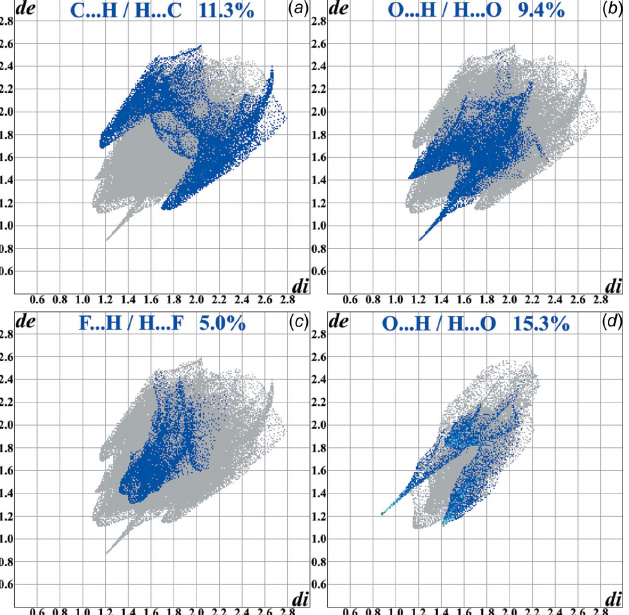
Figure 6 Comparison of the Hirshfeld surfaces of the 2-propanol molecule in positions A and B .